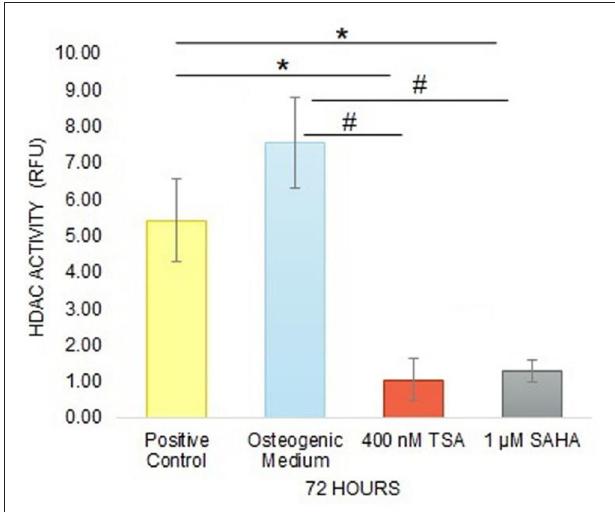
FIGURE 3 | The inhibitory effect of TSA and SAHA in HDAC activity inhibition was evaluated by a HDAC activity assay after 72h treatment in hDPC culture (one-way ANOVA, Tukey’s HSD post hoc test, Asterisks indicate a significant difference compared with positive control at p < 0.05, Hashtags indicate a significant difference compared with osteogenic medium at p < 0.05, n =